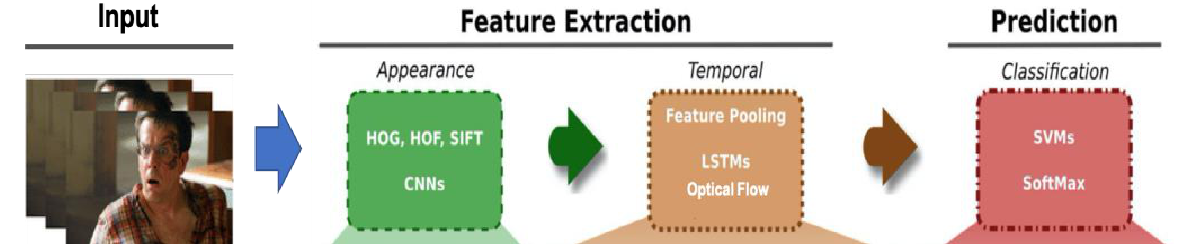
Figure 5. An overview of video classification process.